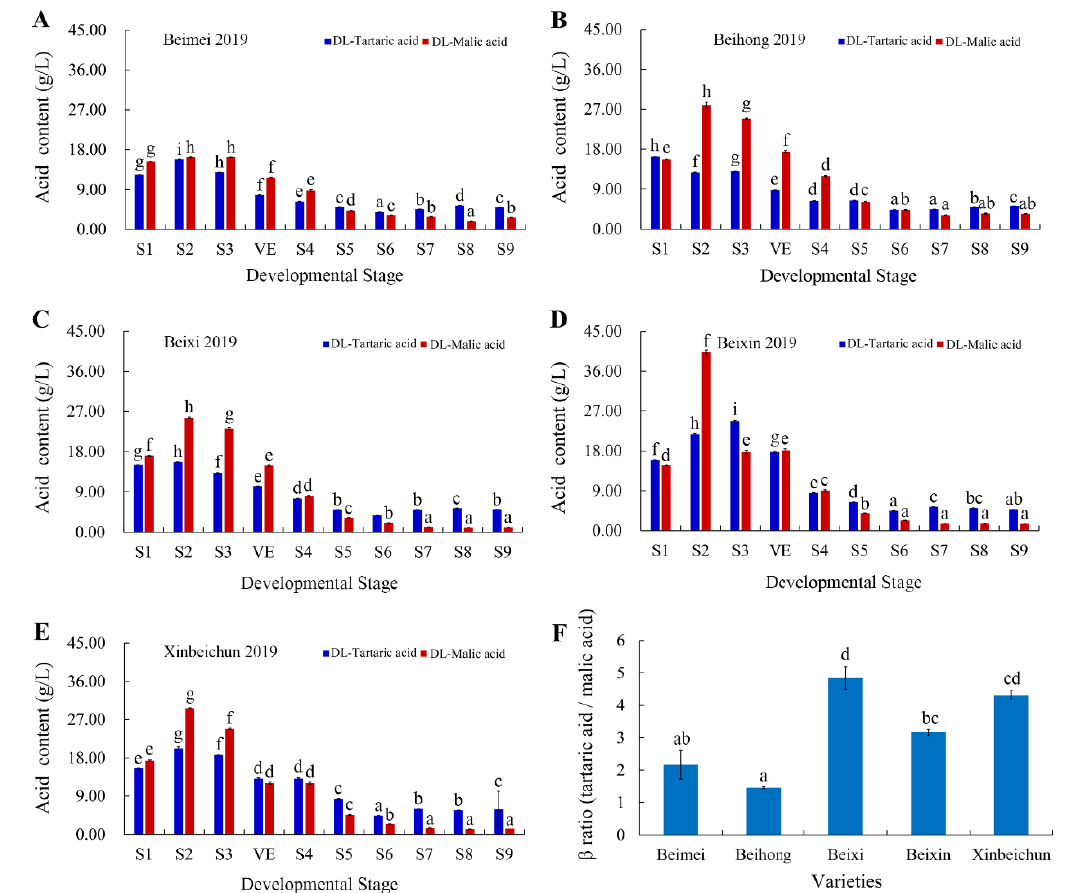
Figure 7. Acid content changes at different development stages of ‘Beimei’ ( A ), ‘Beihong’ ( B ), ‘Beixi’ ( C ), ‘Beixin’ ( D ) and ‘Xinbeichun’ ( E ), ‘Variety’ ( F ). S1 sampling date was 19 June 2019. S2 sampling date in 2021 was 8 July. S1 – S9 were sampled once every two weeks, VE = veraison. Data are mean values of three repeats. The error bars indicate the SE from repeats. the letters above the bars indicate significant differences ( p < 0.01, determined by one-way ANOVA).